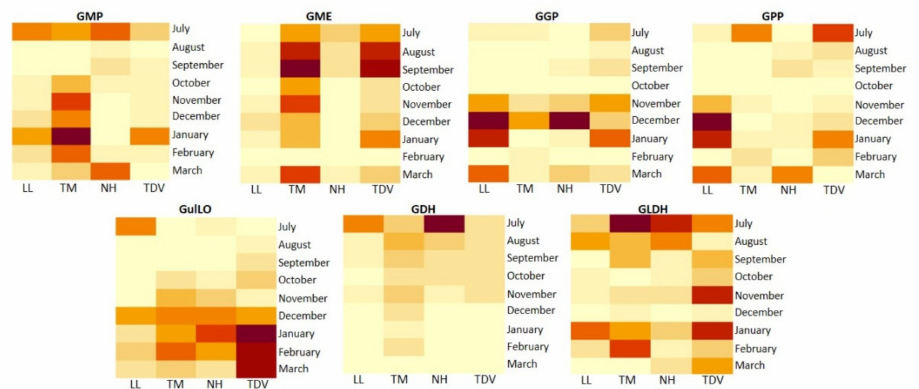
Figure 5. Heatmap of gene expression involved in the L -galactose and L -gulose pathways in the juice of Lanelate (LL), Tarocco Meli (TM), Newhall (NH), and Tarocco TDV (TDV) genotypes from July to March. Gene expression decreases according to the colour scale, from rust red to creamy